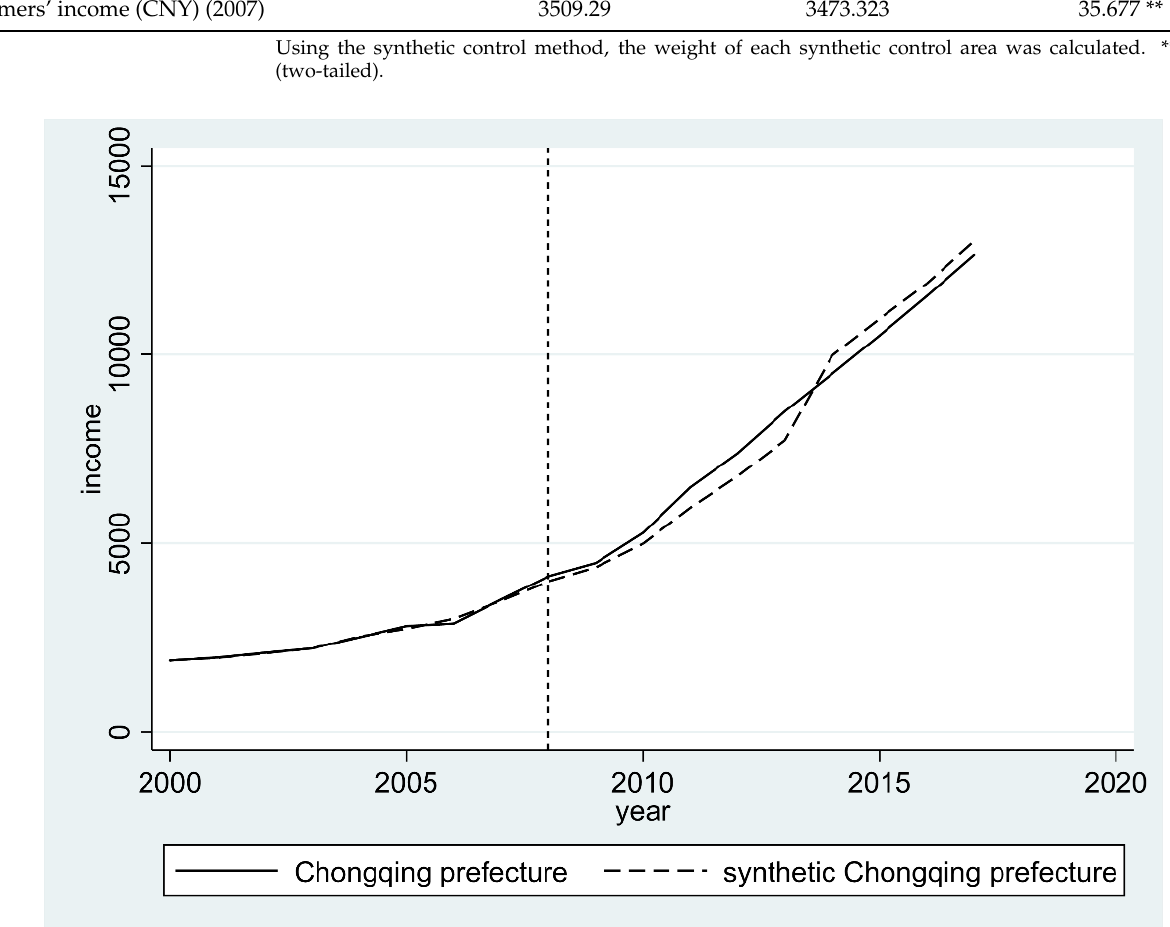
Figure 4. Changes in farmers ’ income in real Chongqing and synthetic Chongqing.